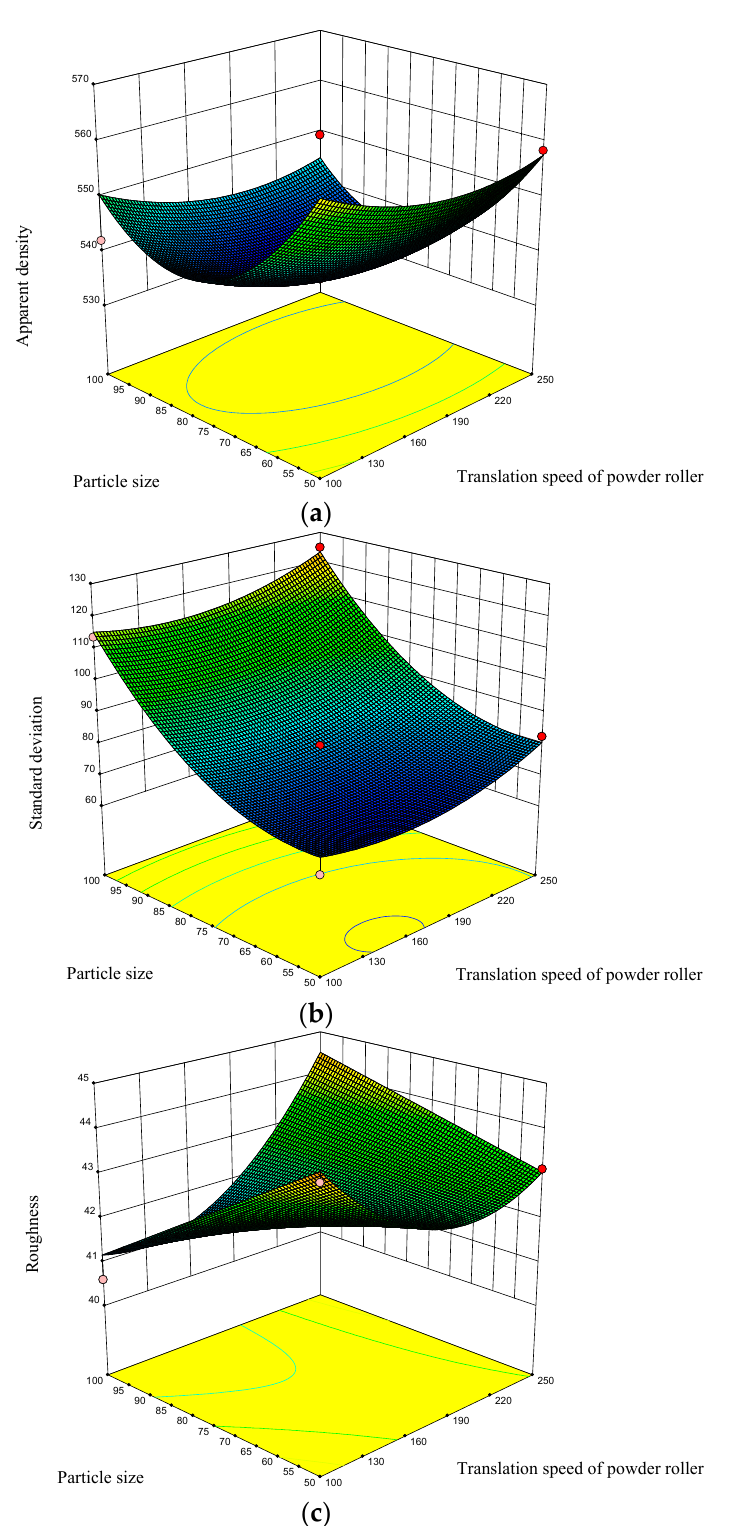
Figure 6. Response surface diagram of powdery mass from DEM simulation: ( a ) performance density; ( b ) standard deviation of the density; ( c ) roughness.